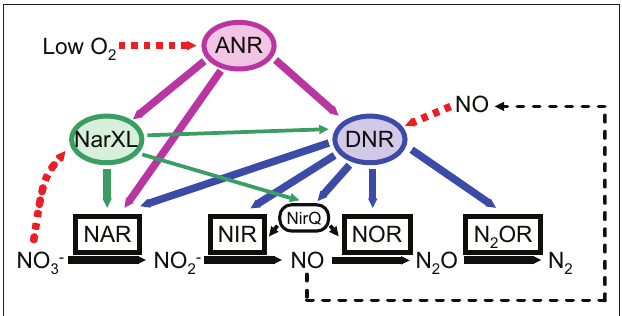
Figure 3 | Schematic model of the regulatory network controlling the denitrification genes in P. aeruginosa . ANR activates the expression of DNR under anaerobic or low oxygen conditions. DNR activates the expression of all denitrification genes in response to nitric oxide. A two-component nitrate sensing regulator, NarXL is required for expression of the nar genes encoding nitrate reductase. Both ANR and DNR can activate the nar gene expression. NirQ is predicted to be involved in the fine tuning of the activities of nitrite reductase and nitric oxide reductase. NAR, NIR, NOR, and N nitrate reductase, nitrite reductase, nitric oxide reductase, and nitrous oxide